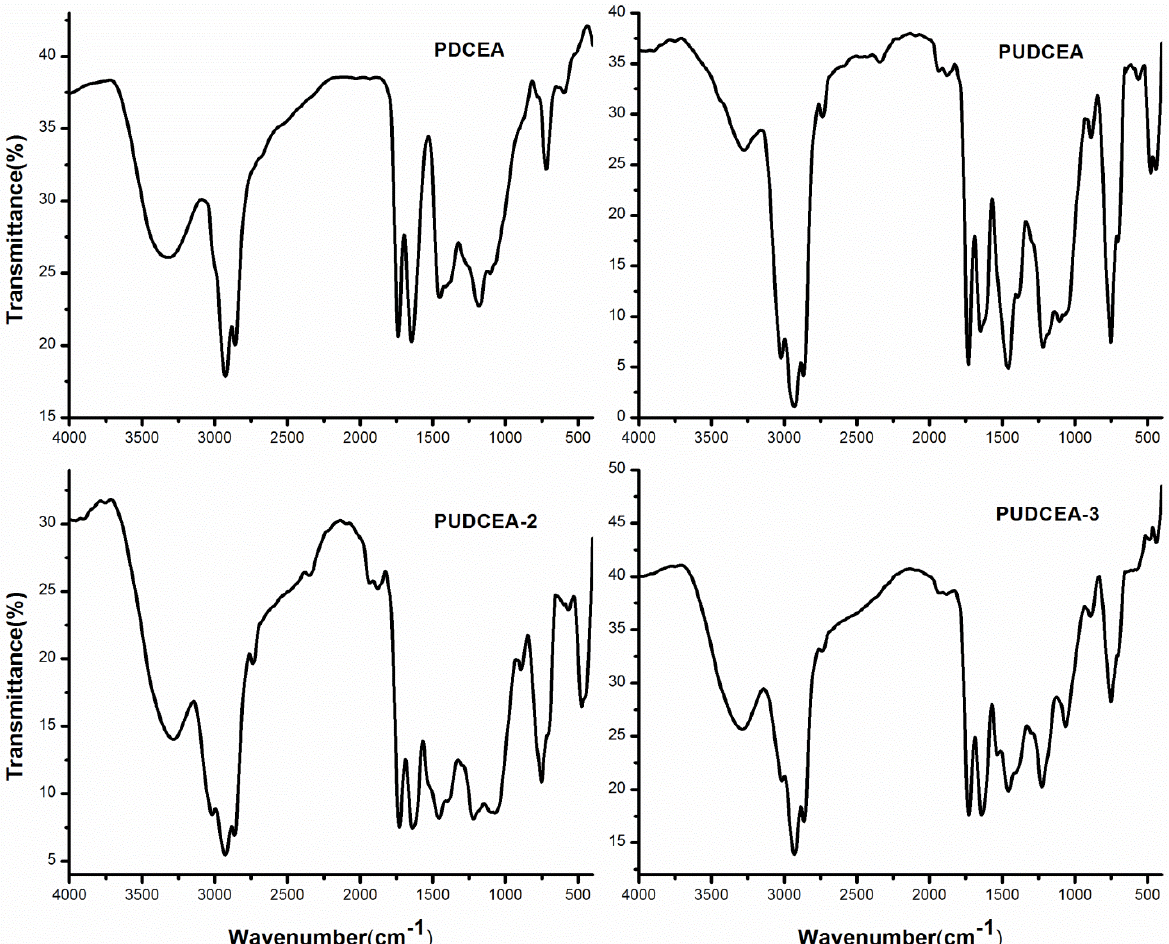
Figure 2. FTIR spectra of PDCEA,PUDCEA,PUDCEA-1and PUDCEA-2 Figure 2: FTIR spectra of PDCEA,PUDCEA,PUDCEA-1and